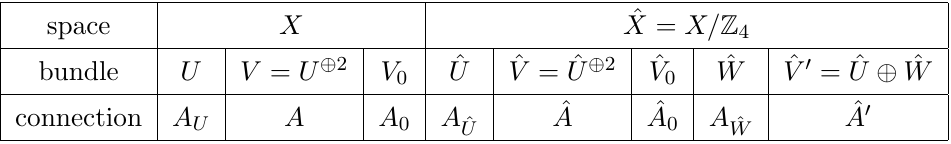
Table 1 . Bundles and associated connections of our